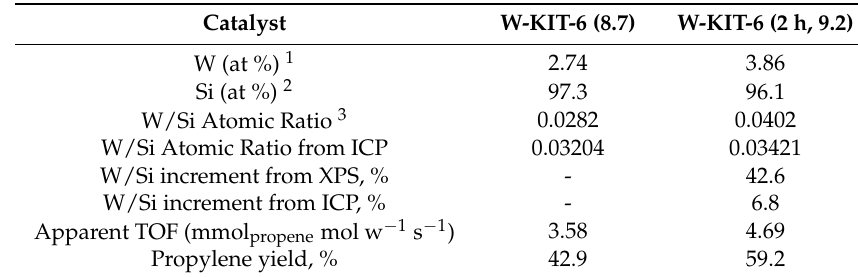
Table 2. Atomic ratio of W/Si in W-KIT-6 catalysts measured from XPS and ICP revealing surface enrichment